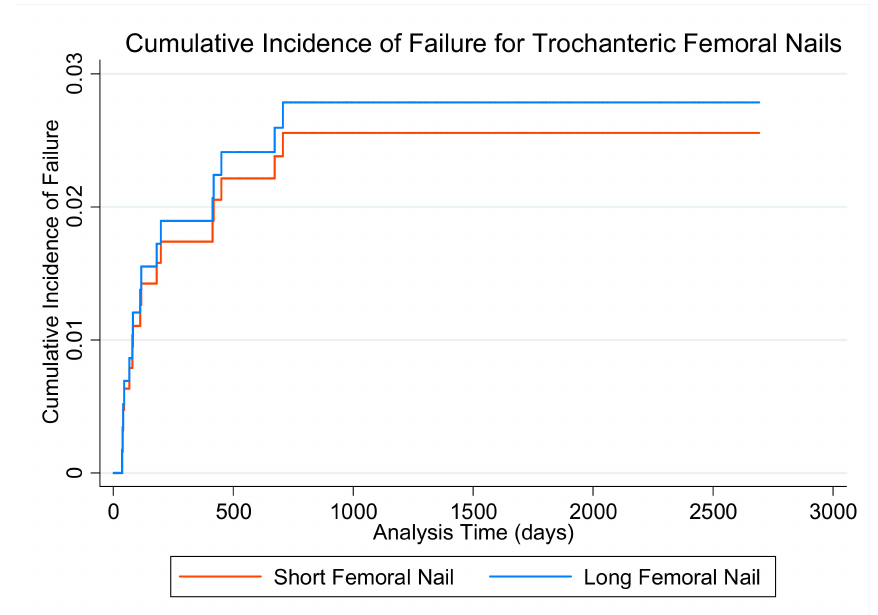
Figure 4. Cumulative incidence of failure for short and long trochanteric